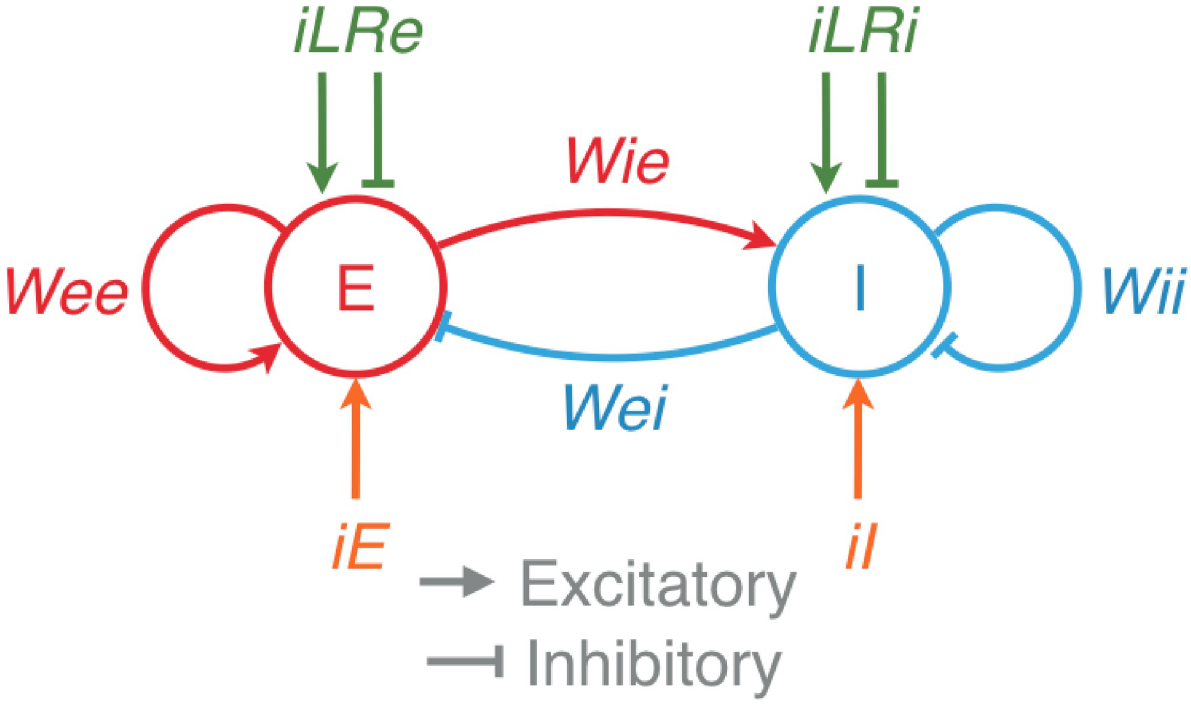
Fig 7. A resonant model of gamma oscillations. A schematic of the model with an excitatory population (E) and an inhibitory population (I). iE and iI are the external inputs, and iLRe and iLRi are inputs from other nearby local recurrent networks. Wee , Wei , Wie , and Wii are the gains of the corresponding connections between the